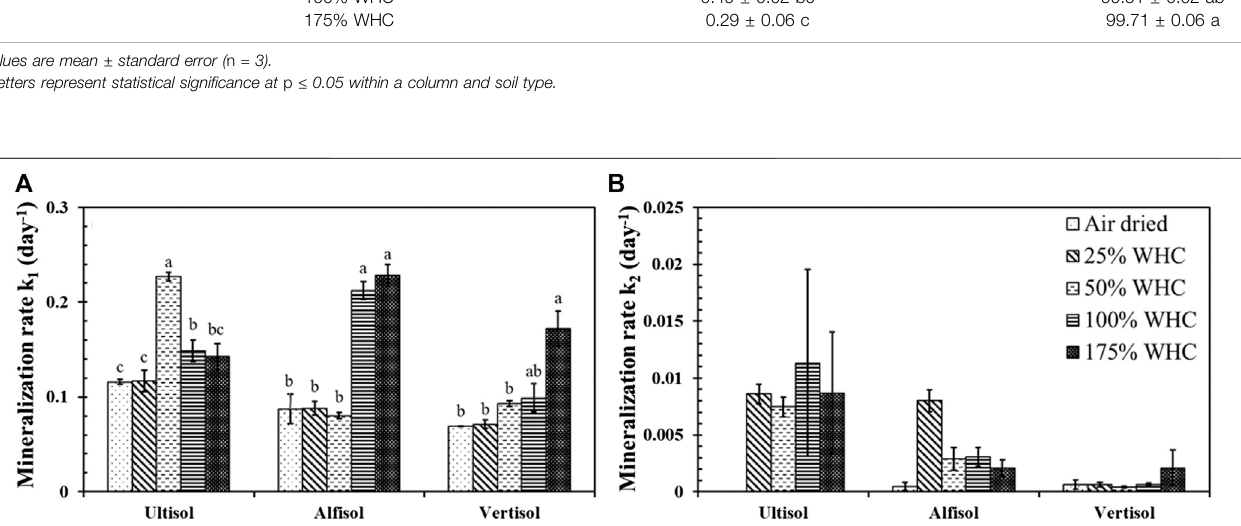
FIGURE 3 | Effect of soil moisture levels on k 1 , the mineralization rates of active SOC pool (A) and k 2 , the mineralization rate of slow SOC pool (B) in Ultisol, Al fi sol and Vertisol soils. Different letters represent statistical signi fi cance at p ≤ 0.05 within each soil type. No letters mean no statistical signi fi cance. Error bars represent standard error ( n (cid:1)